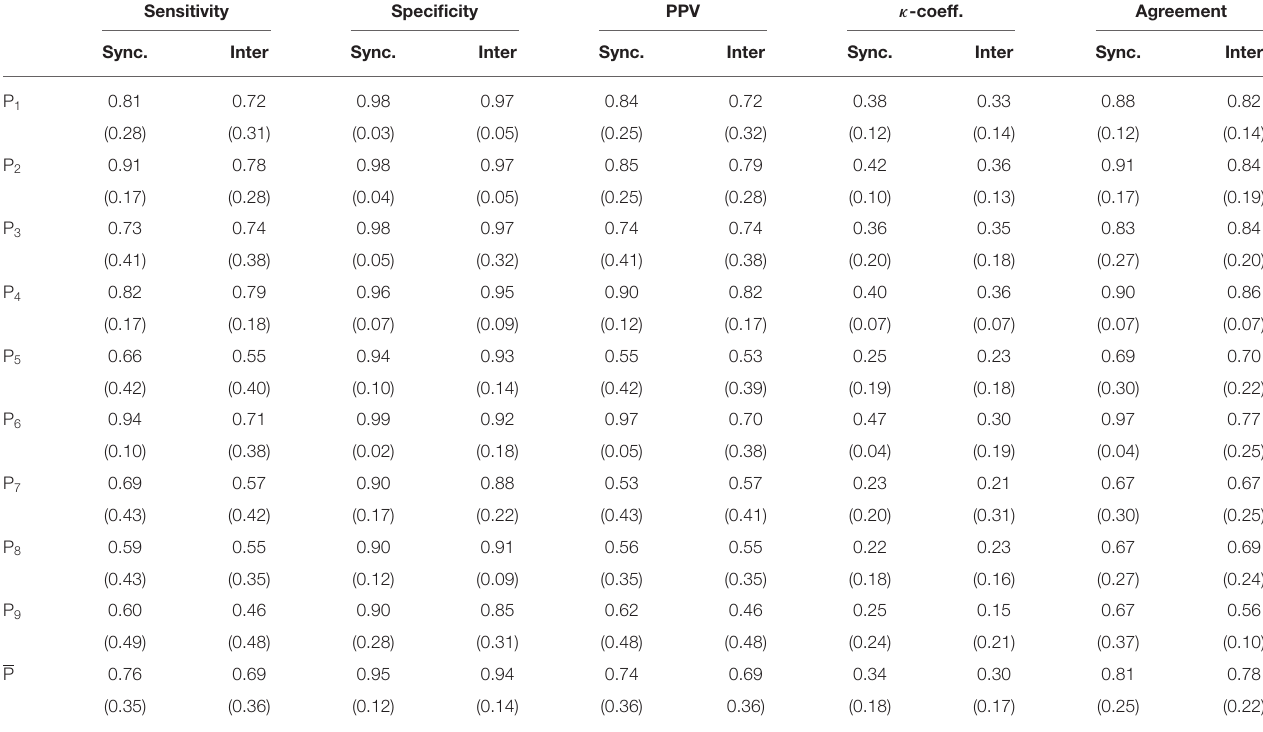
TABLE 4 | Sensitivity (Se), specitify (Sp), PPV, κ -coefficient, and agreement between (i) the experts and the automatic scoring by SyncSmart and (ii) between experts, successively computed for each patient. Sensitivity Specificity PPV κ -coeff.